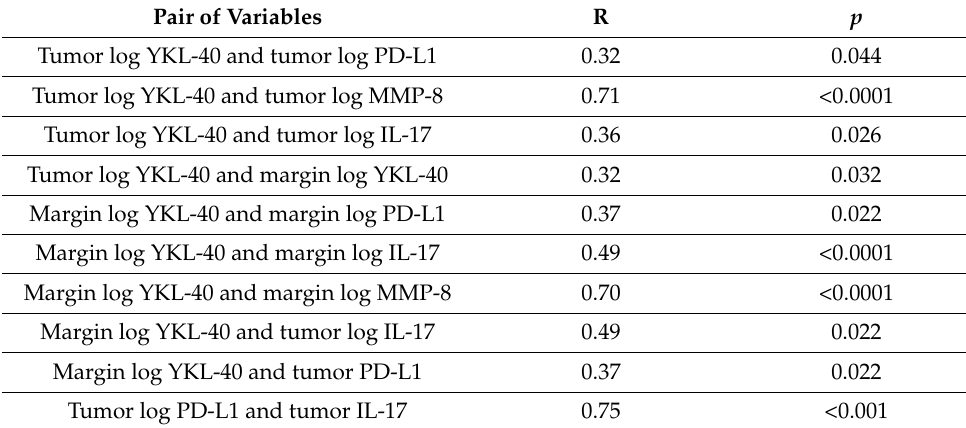
Table 3. Correlations between the YKL-40 levels and the examined molecules. R—Pearson’s correla- tion